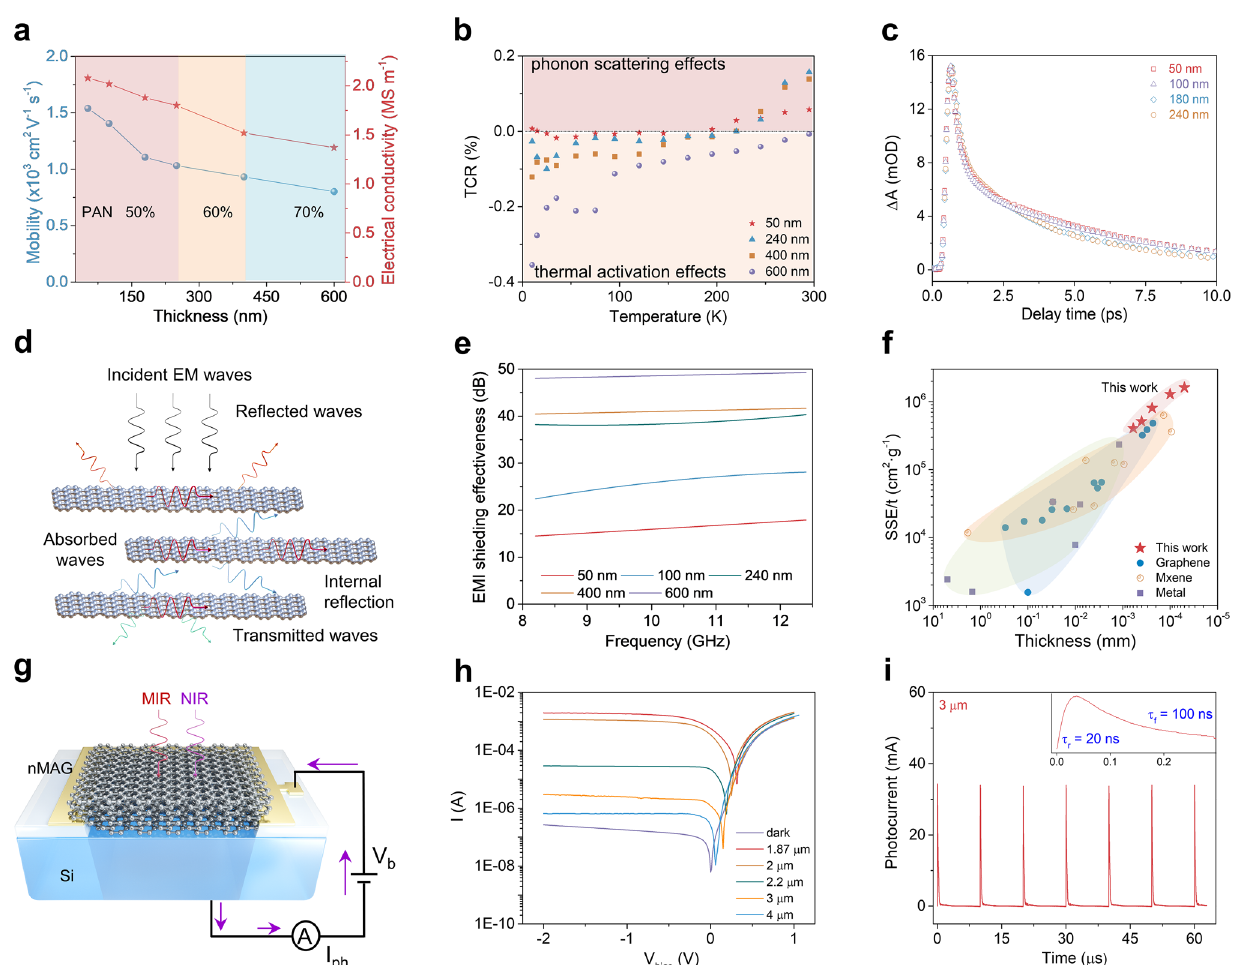
Fig. 4 Electrical properties and applications of nMAGs. a Carrier mobility and electrical conductivity of nMAGs. b TCR of nMAGs with dif- ferent thicknesses. c Transient absorption kinetics of nMAGs with different thicknesses (power density, 1 mW mm −2 ; pump wavelength, 532 nm; probe wavelength, 1.4 μm). d Schematic illustration of the electromagnetic shielding mechanism of nMAG. e EMI SE of nMAGs of different thicknesses of 50, 100, 240, 400, and 600 nm. f Comparison of SSE/t among different EMI materials (see Table S4 for details) in X-band versus thickness. g Schematic of the nMAG/Si Schottky diode. h I-V curves of nMAG/Si under laser illumination at different wavelengths (average power density 40 mW mm. −2 ). i Photocurrent of nMAG/Si in time domain under pulsed-laser (200 fs pulse width) illumination at 3 µm wave- length (τ r = 20 ns is the rising time, which means the time of signal rising from lowest point to highest